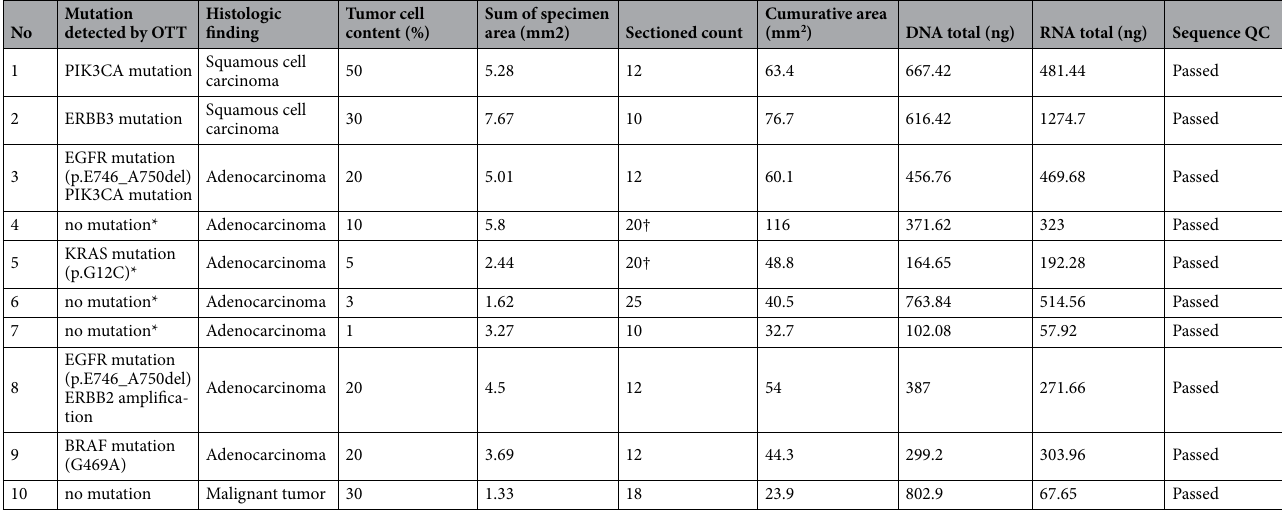
Table 3. Results of OTT analysis. OTT Oncomine™ Target Test. *Tumor cell content in these patients was lower than the predetermined threshold. † In samples from these patients, cellularity was poor; thus, the section count